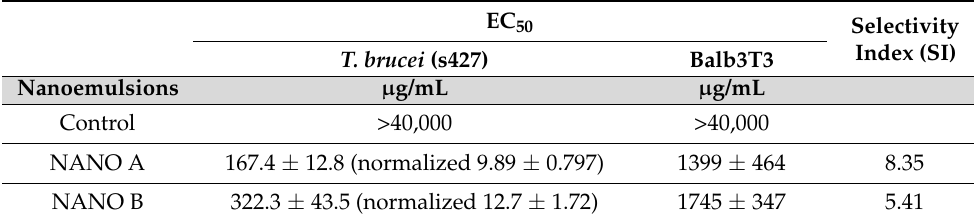
Table 5. Antitrypanosomal activity of A.nemorosa EO from aerial parts (EO-AP) and nanoemulsions using NANO A and NANO B.